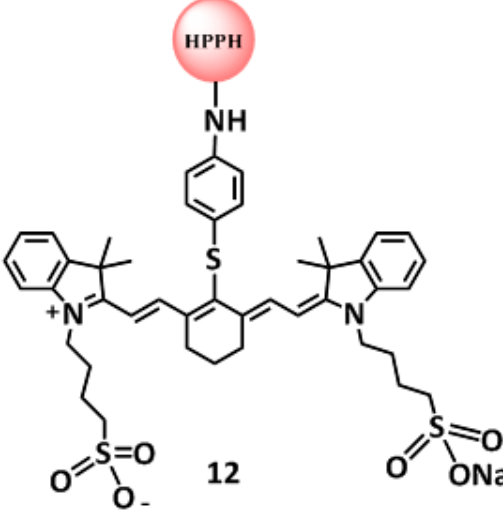
Figure 7. Structure of HPPH-CD conjugate 12 .